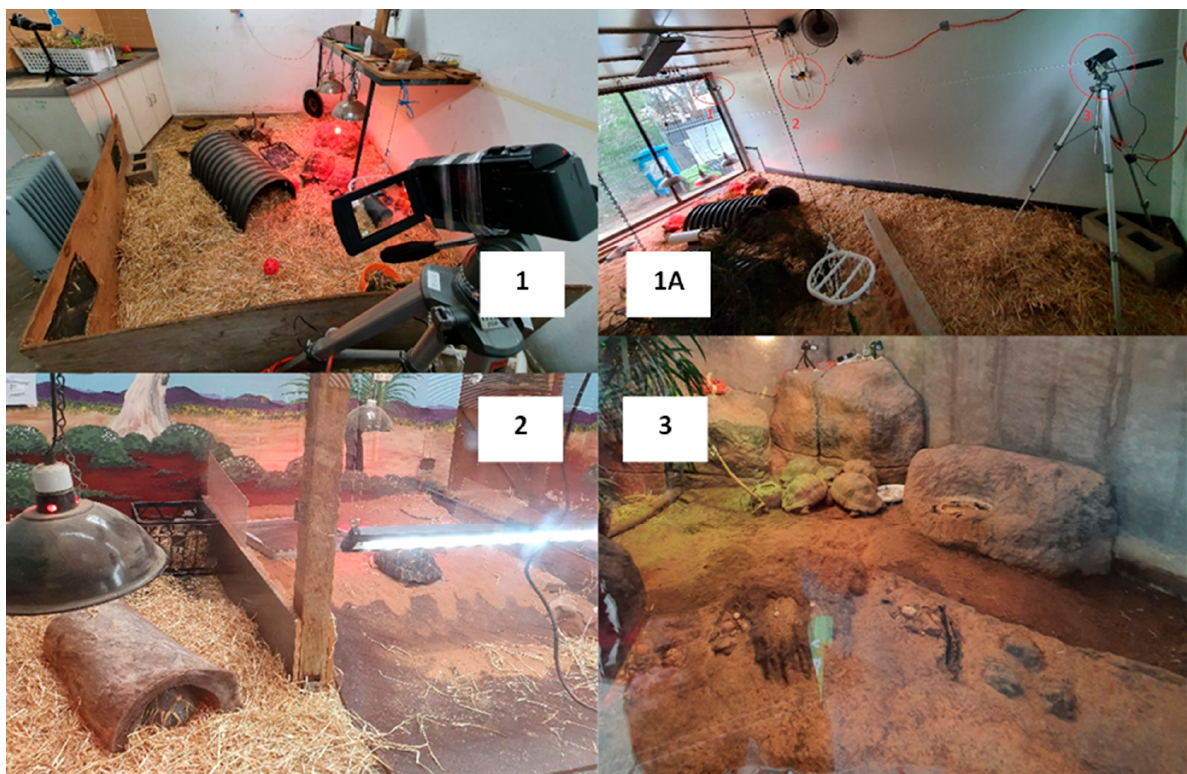
Figure 1. Photographs of enclosures 1 (the original leopard tortoises enclosure), 1A the indoor component of the new leopard tortoise enclosure, 2 radiated tortoise enclosure, and 3 Aldabra tortoise enclosure.